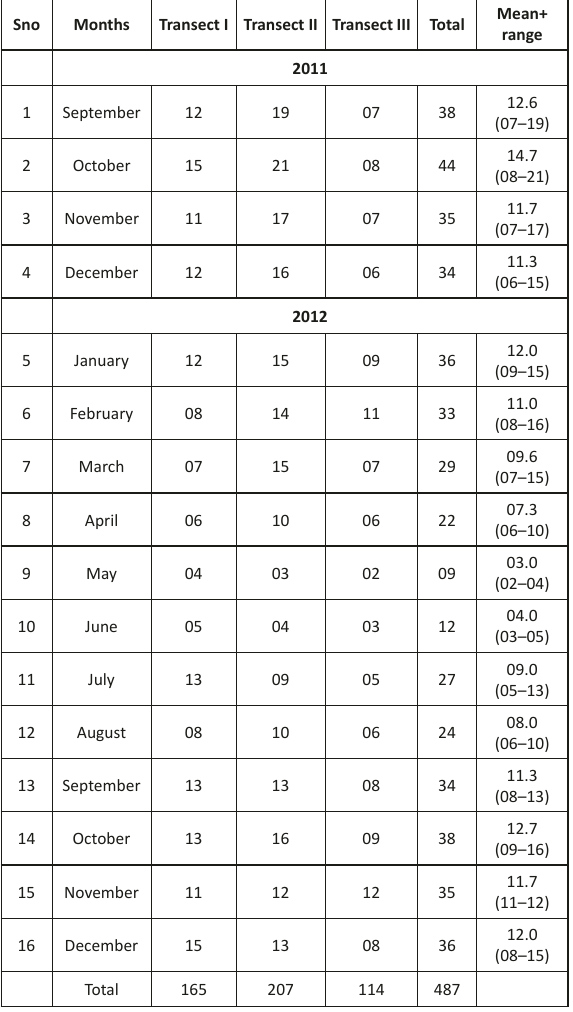
Table 1. The overall month-wise distribution of Sarus Crane and their mean numbers in different transects of Alwara Lake in district Kaushambi.